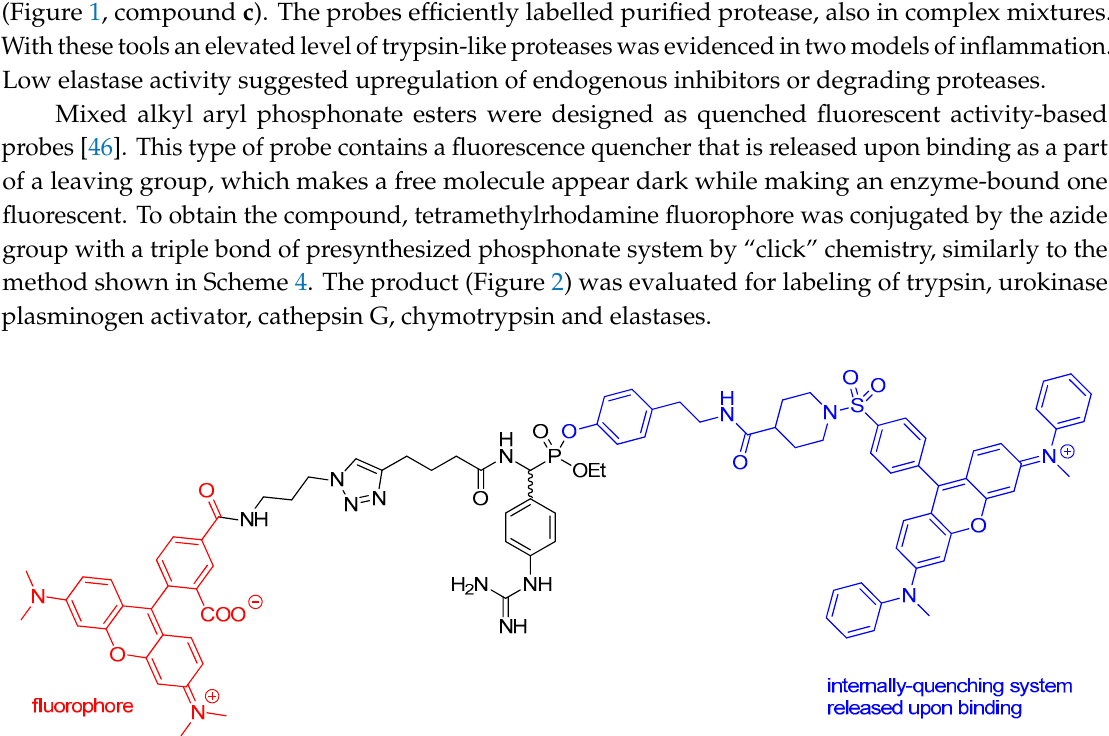
Figure 2. The structure of an internally-quenched fluorescent activity-based probe for labeling of arginine-specific serine proteases.